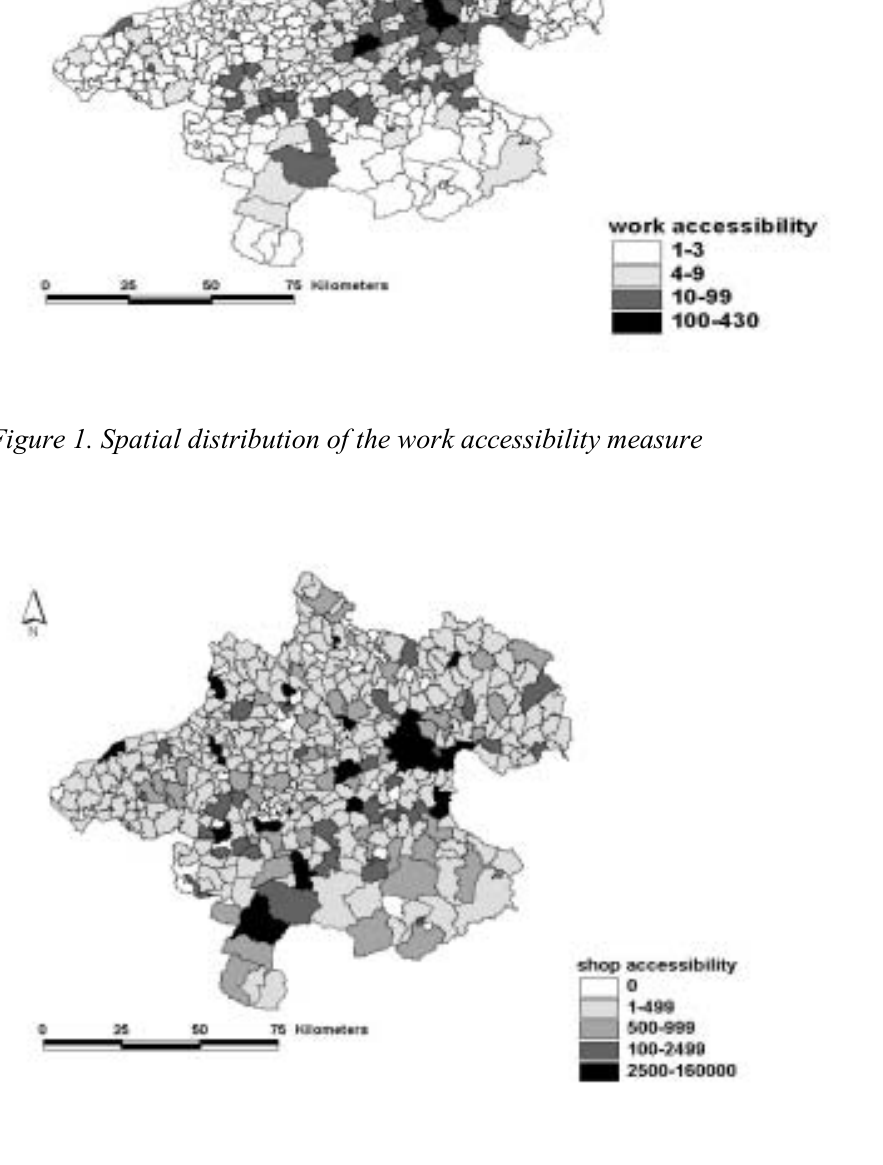
Figure 2. Spatial distribution of the shop accessibility